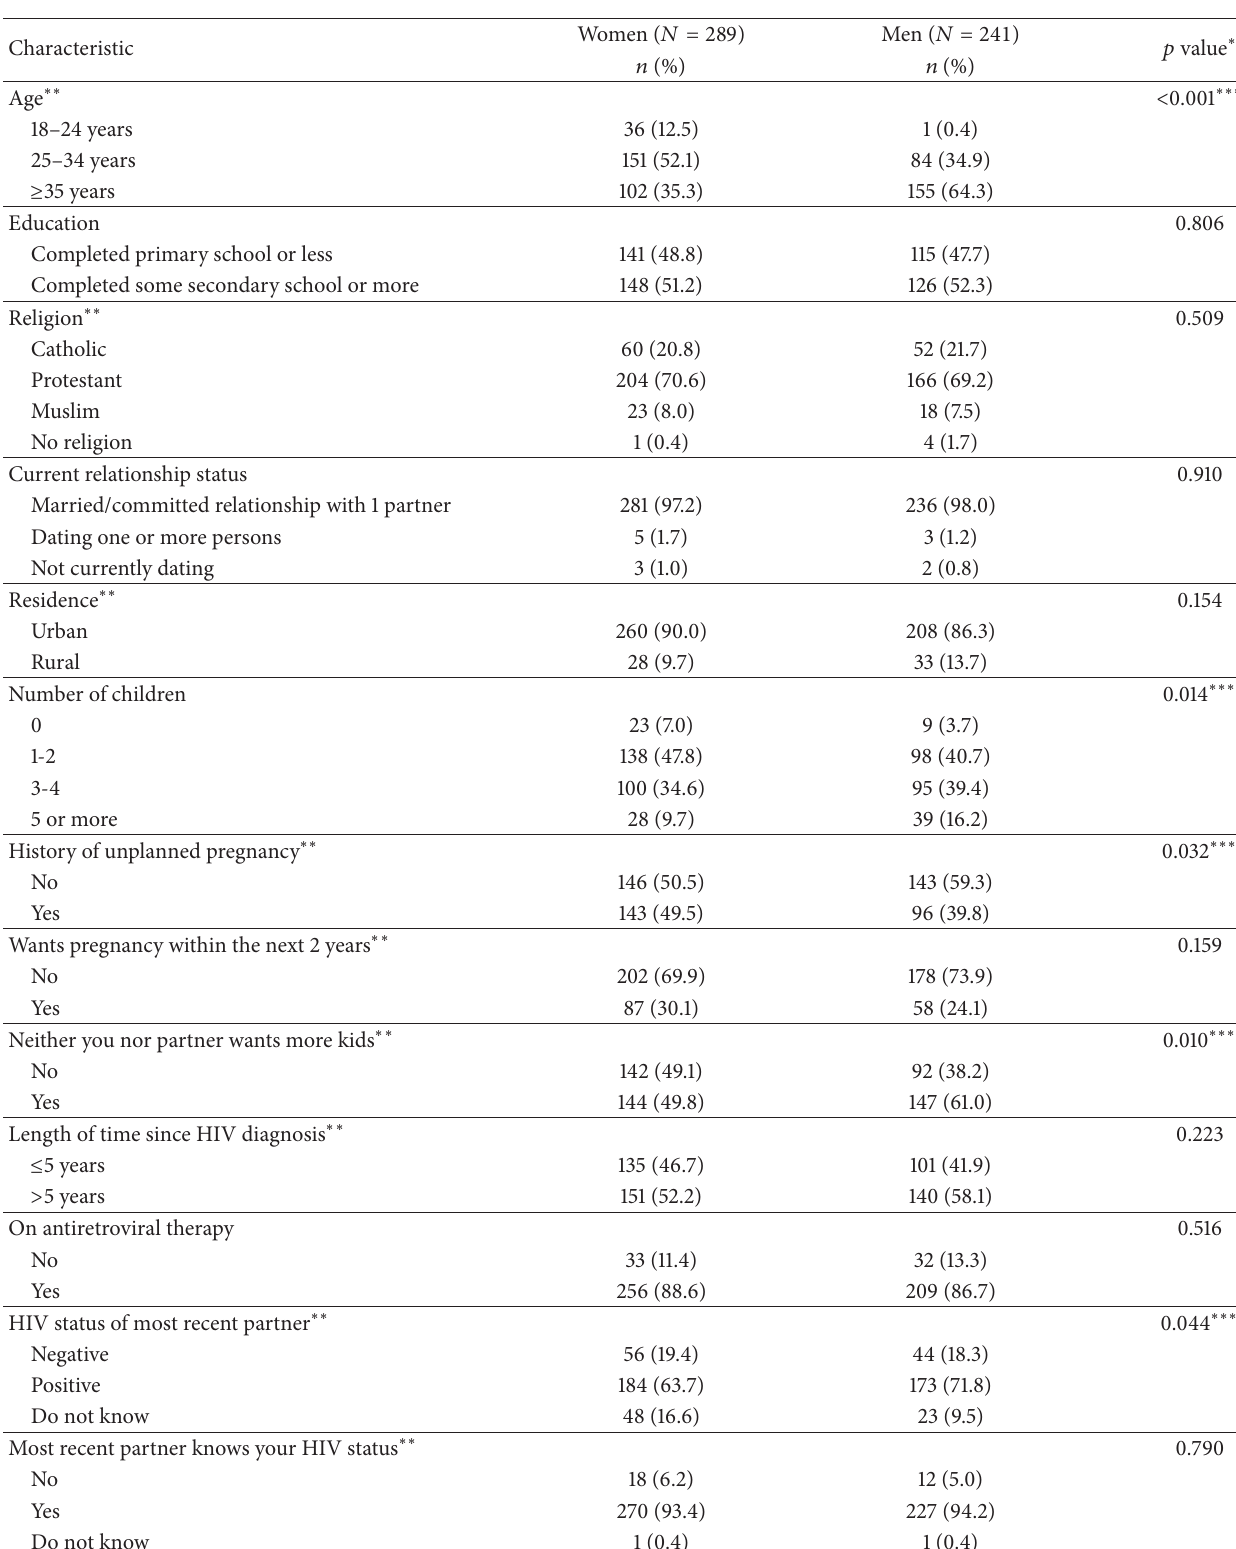
Table 1: Baseline characteristics of participants (by